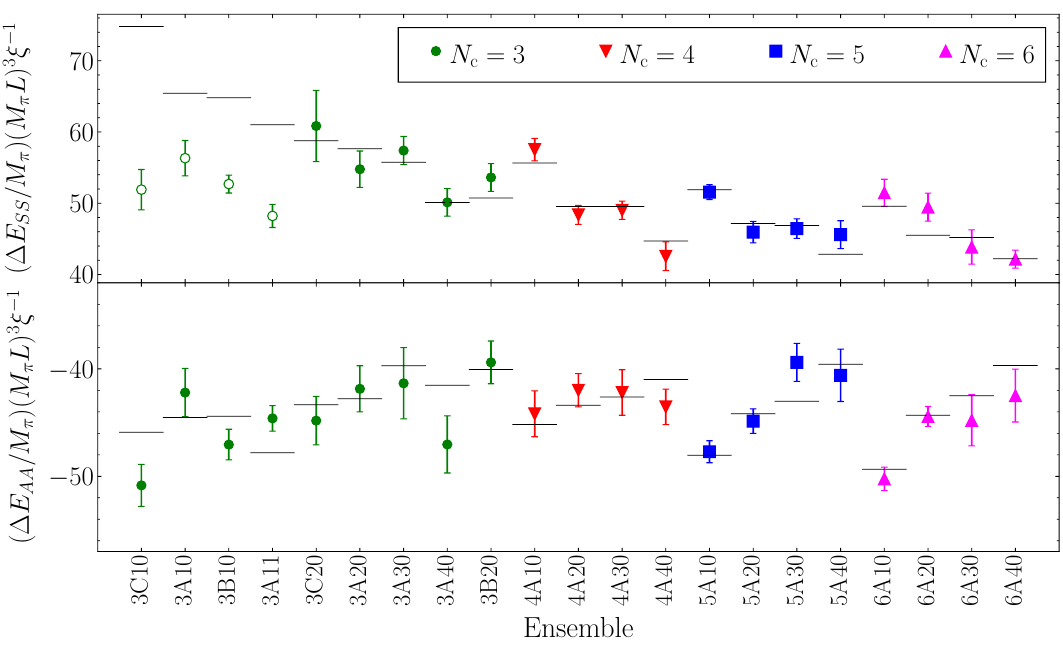
Figure 13 . Results for the simultaneous chiral and N c fit of the energy shifts for both SS (top) and AA (bottom) channels. Lattice results are depicted as points, with a different marker for different N c as explained in the plot legend. Empty points in the SS channel are not fitted. Horizontal lines correspond to the best fit to U(4) ChPT, summarized in table 8. The values are multiplied by ( M ) 3 ξ − 1 to eliminate leading chiral and N π L c